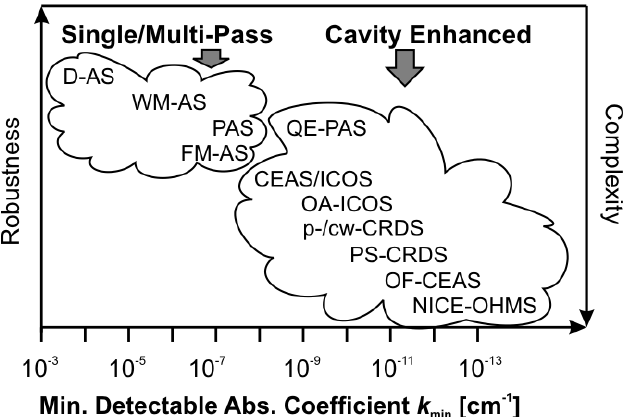
Figure 1. Comparison of selected absorption spectroscopy (AS) techniques according to their typically achieved minimum detectable absorption coefficients, k and complexity. Abbreviations which are not explained in the text can be found in appendix A.1 (adapted from